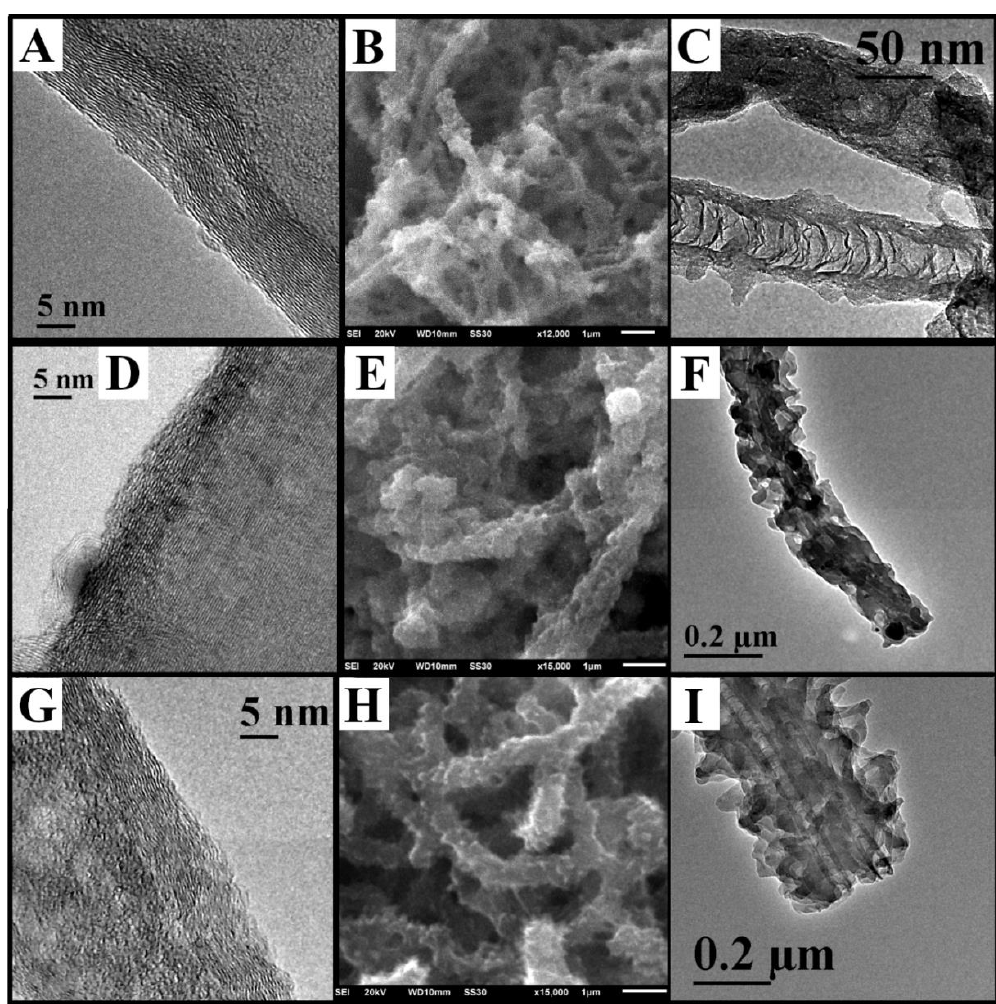
Figure 1. TEM images of uCNT ( A ), N-CNT ( D ), and N + -CNT ( G ); SEM and TEM images of PANI/uCNT ( B , C ), PANI/N-CNT ( E , F ) and PANI/N + -CNT ( H , I ) composites.